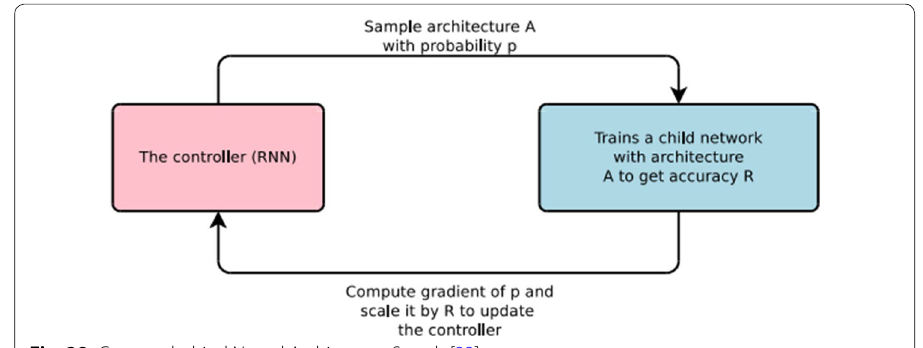
Fig. 28 Concept behind Neural Architecture Search